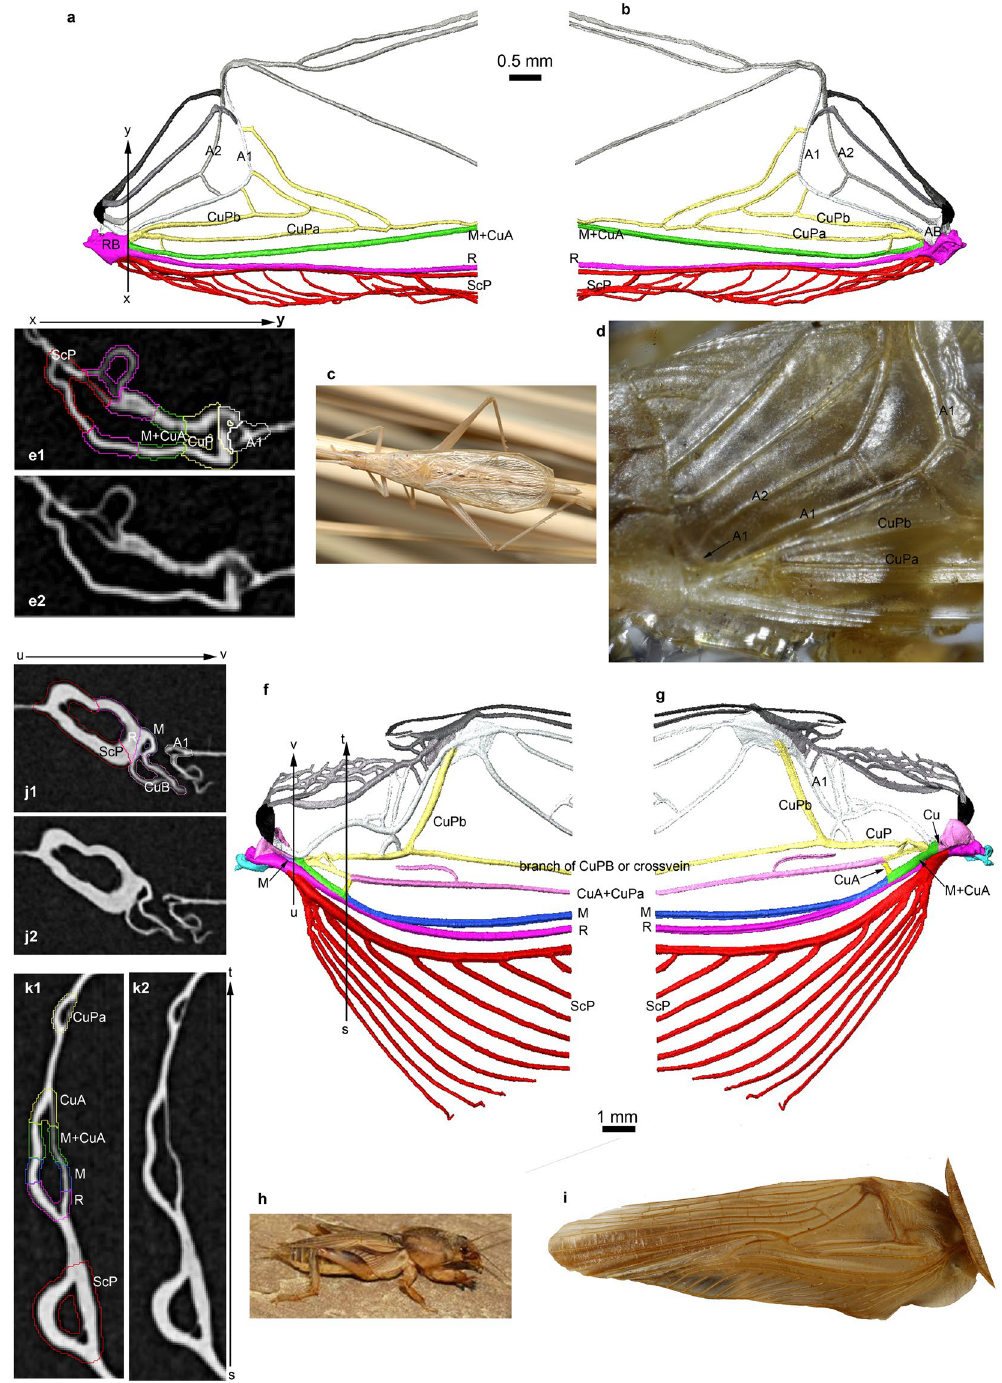
Figure 1. Wing venation interpretations. ( a – e ) Gryllidae ( Oecanthus sp.). ( a ) 3D modeling of wing venation using XMT, view from above. ( b ) 3D modeling of wing venation using XMT, view from below. ( c ) General habitus (copyright S. Hugel). ( d ) Complete tegmen (copyright L. Desutter-Grandcolas). ( e ) Cut xy (1 colored; 2 without color; orientation of tomogram plane YZ, tomogram number 1035). ( f – k ) Gryllotalpidae ( Scapteriscus sp.). ( f ) 3D modeling of wing venation using XMT, view from above. ( g ) 3D modeling of wing venation using XMT, view from below. ( h ) General habitus (copyright S. Hugel). ( i ) Complete tegmen (copyright L. Desutter- Grandcolas). ( j ) Cut uv (1 colored; 2 without color; orientation of tomogram plane XZ, tomogram number 1043). ( k ) Cut st (1 colored; 2 without color; orientation of tomogram plane XZ, tomogram number 876). (3D XMT L.